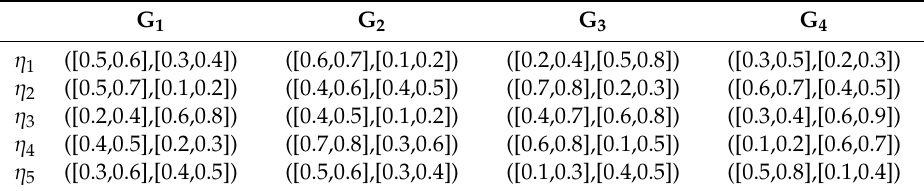
Table 3. The q-RIVOFNs information given by D 3